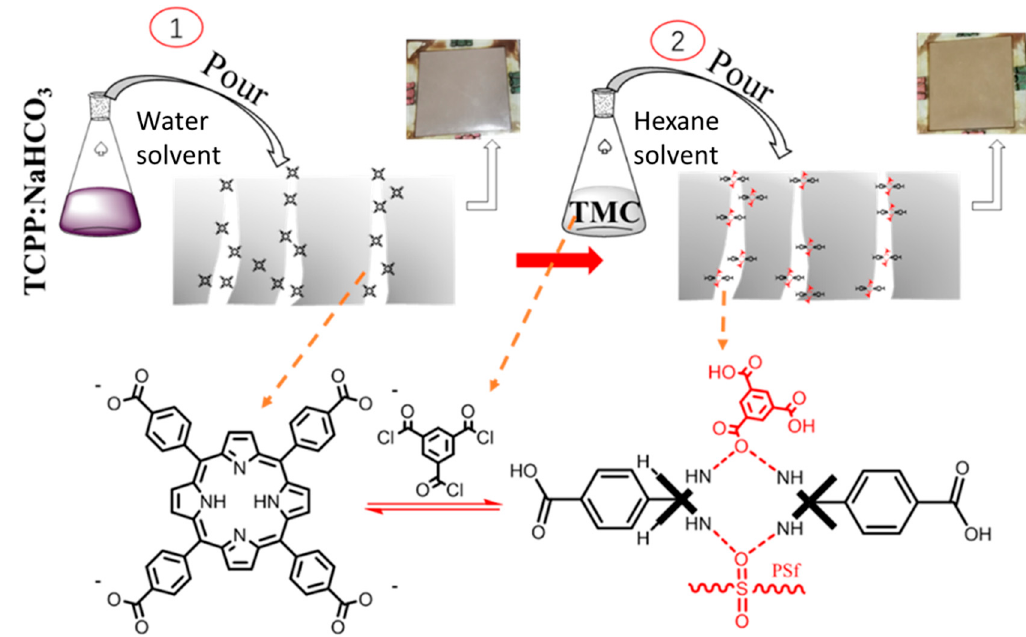
Figure 1. Schematic diagram of tetrakis (4-carboxyphenyl) porphyrin / polysulfone (TCPP / PSf) membranes synthesis route. Table 2. Labels of TCPP/PSf membrane and corresponding aqueous solution concentration.